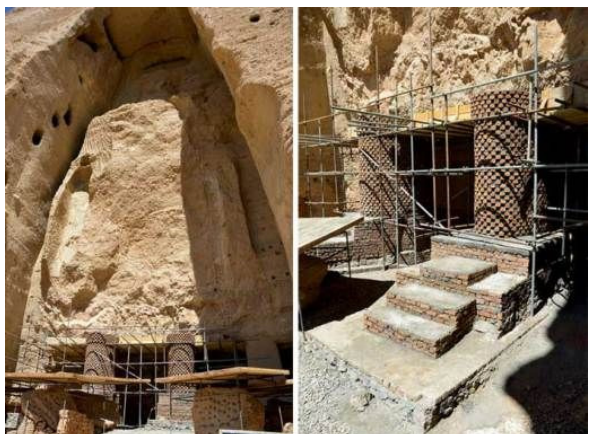
Figure 2. Situation at the bottom of the 38m Buddha niche by end of 2014 (Source: UNESCO)